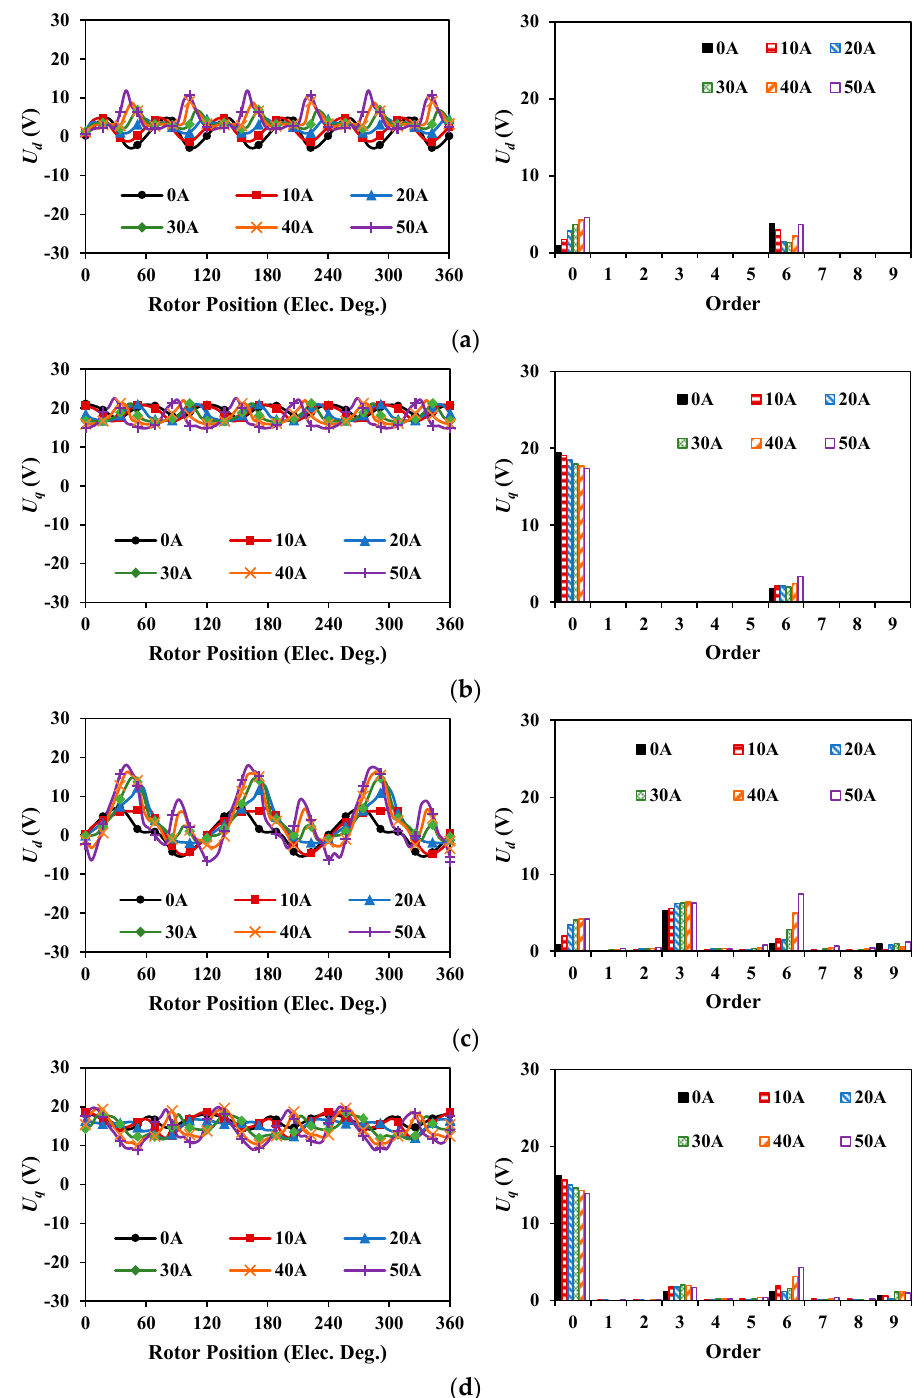
Figure 14. Back-EMFs and spectra for 12s8p machines. ( a ) D-axis back-EMF of 12s8p-SPM. ( b ) Q-axis back-EMF of 12s8p-SPM. ( c ) D-axis back-EMF of 12s8p-CCPPM. ( d ) Q-axis back-EMF of 12s8p-CCPPM.